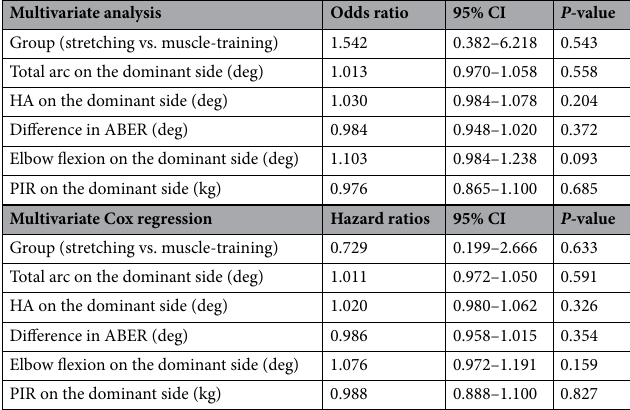
Table 2. Multivariate analysis and Multivariate Cox regression for testing possible bias. Total arc = ABER + ABIR. ABER and ABIR, ROM in 90° shoulder abduction external and internal rotation, respectively. HA, horizontal adduction; Difference = ROM on the dominant side—ROM on the non-dominant side; CI, confidence interval; PIR, prone internal rotation.